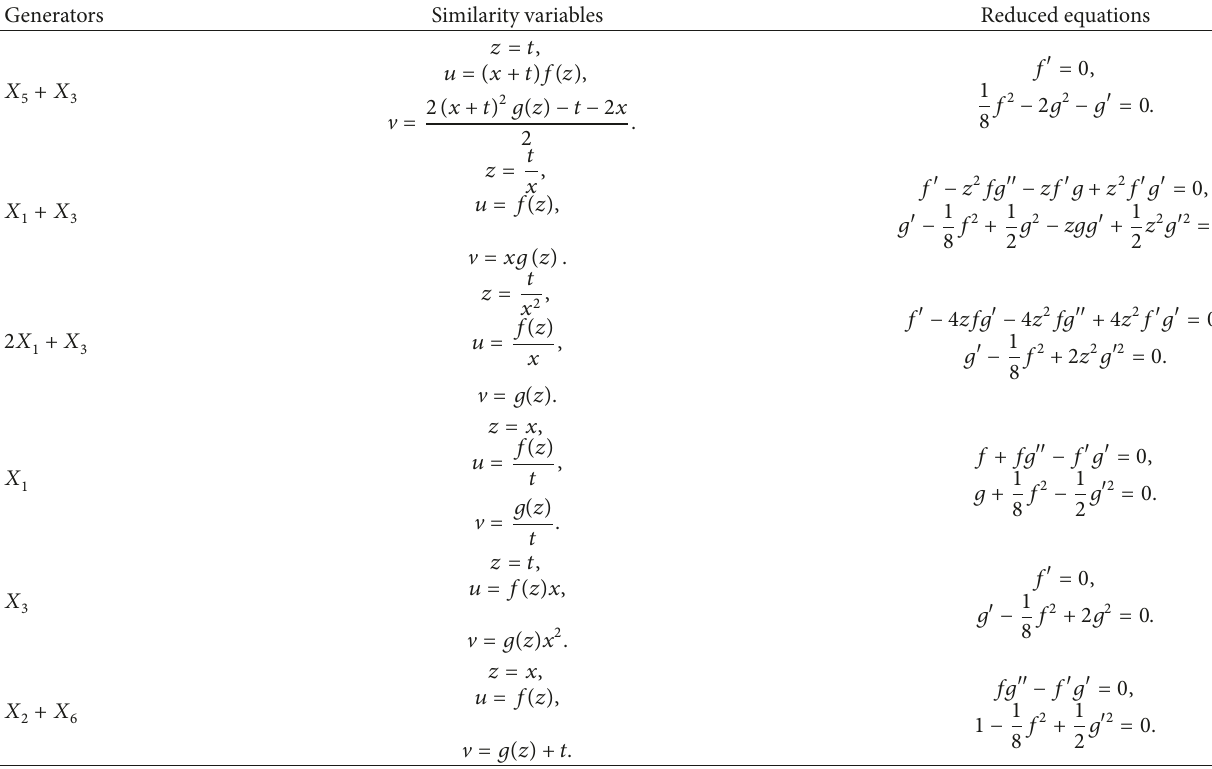
Table 2: The reductions of the two-component Chaplygin gas equation.